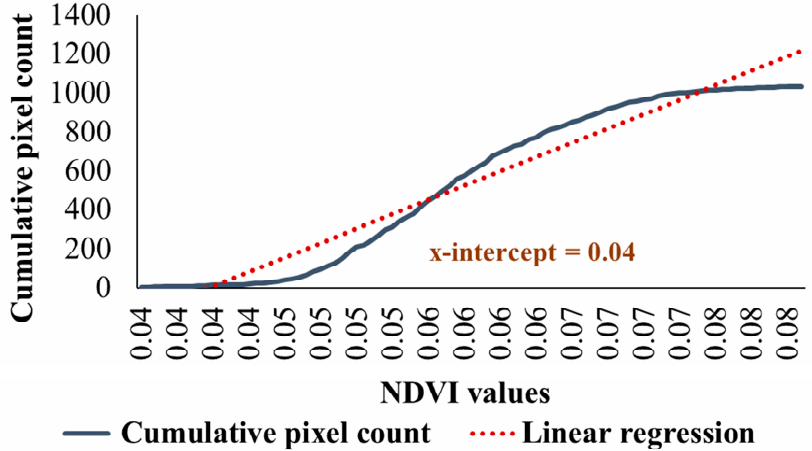
Figure 3. An example of the calculation of x-intercept for one scene.